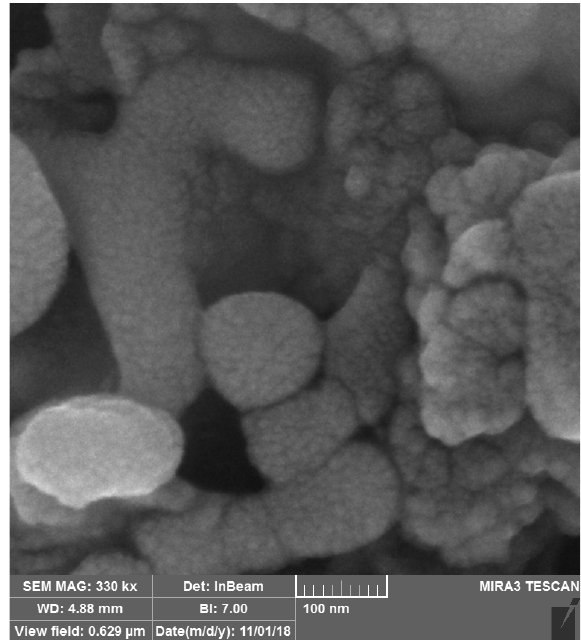
Figure 3. The SEM Image of Se